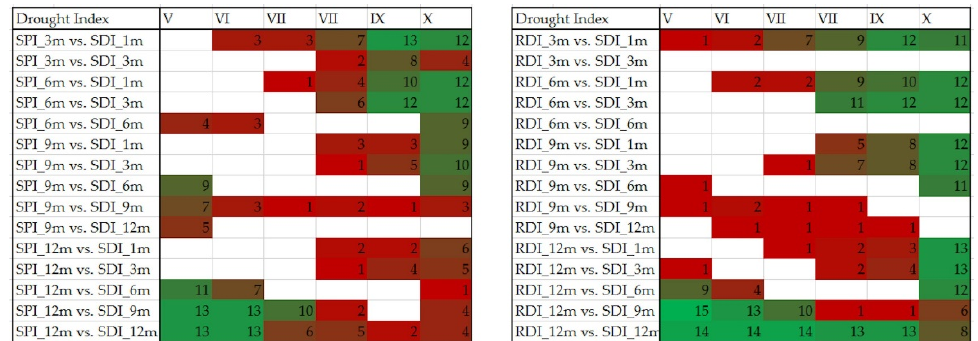
Figure 4. The number of strong correlations among all rivers for each summer month (numbers indicate the number of rivers that had a strong correlation in a particular month, color displays data in ascending order from red (1) to green (15), months without any strong correlation are not colored). The highest number of strong correlations was estimated between RDI-12 and SDI-12, RDI-12 and SDI-9, SPI-12 and SDI-12. For almost all rivers (15 out of 17), a strong correlation was determined between RDI-12 and SDI-9 in May; the correlation coefficient (r) ranged from 0.70 to 0.91, except for the rivers Verkn˙e (r = 0.66) and Str˙eva (r = 0.52). The strongest correlation was found for the Venta River between the RDI-12 and SDI-12 indices for May (0.907). The highest number of strong correlations (r ≥ 0.7) was in October, followed